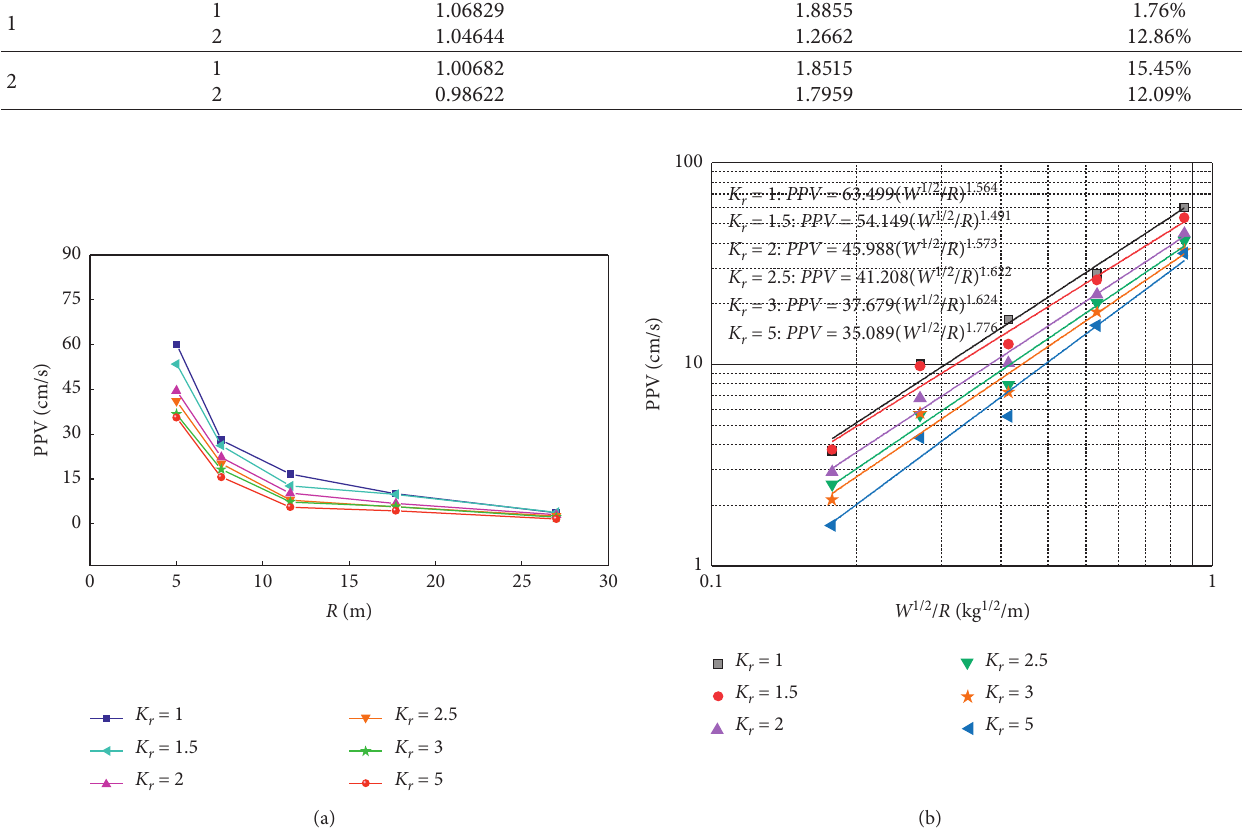
Figure 17: Blasting vibration with different K